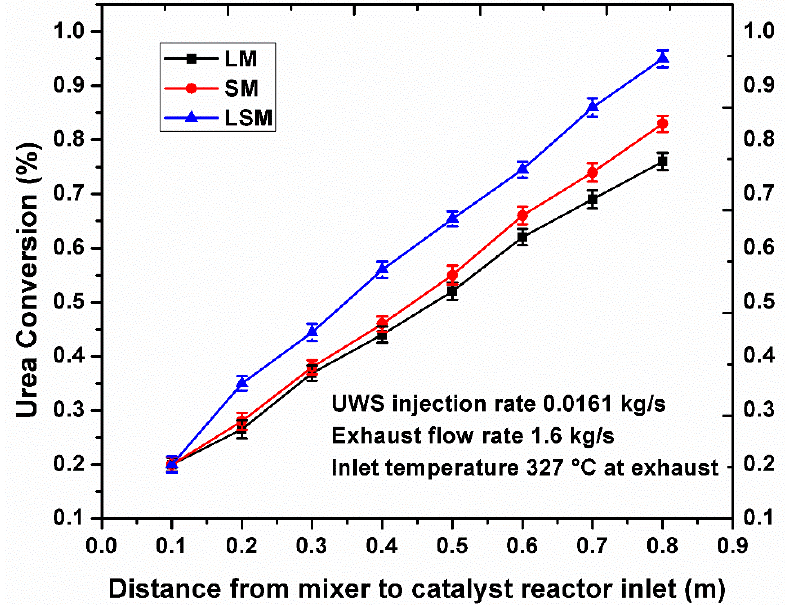
Figure 10. Urea conversion from mixer downstream to catalyst inlet.